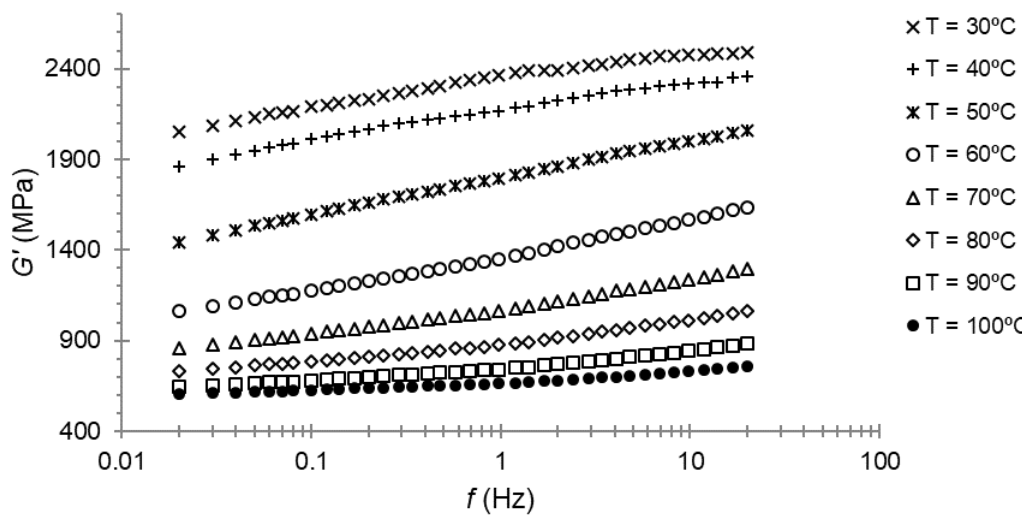
Figure 5. Storage modulus – frequency plot for PA66.